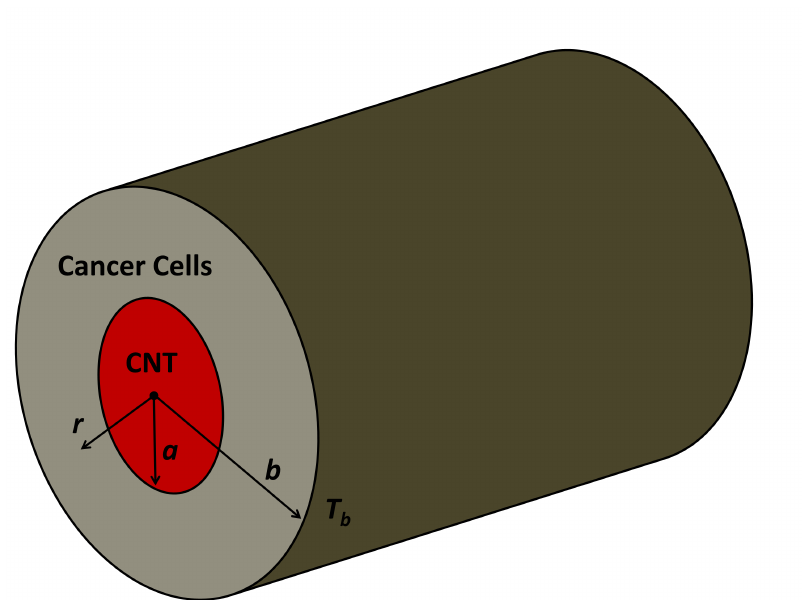
Figure 1. A simple theoretical model of CNT and its surrounding cancer cells during laser heating process. The CNT is modeled by a solid cylinder with the length of CNT is much larger than its diameter. The temperature on the outer side of the cylinder with distance b from the center ( T b ) is assumed to be the temperature of a normal human body 37 ◦